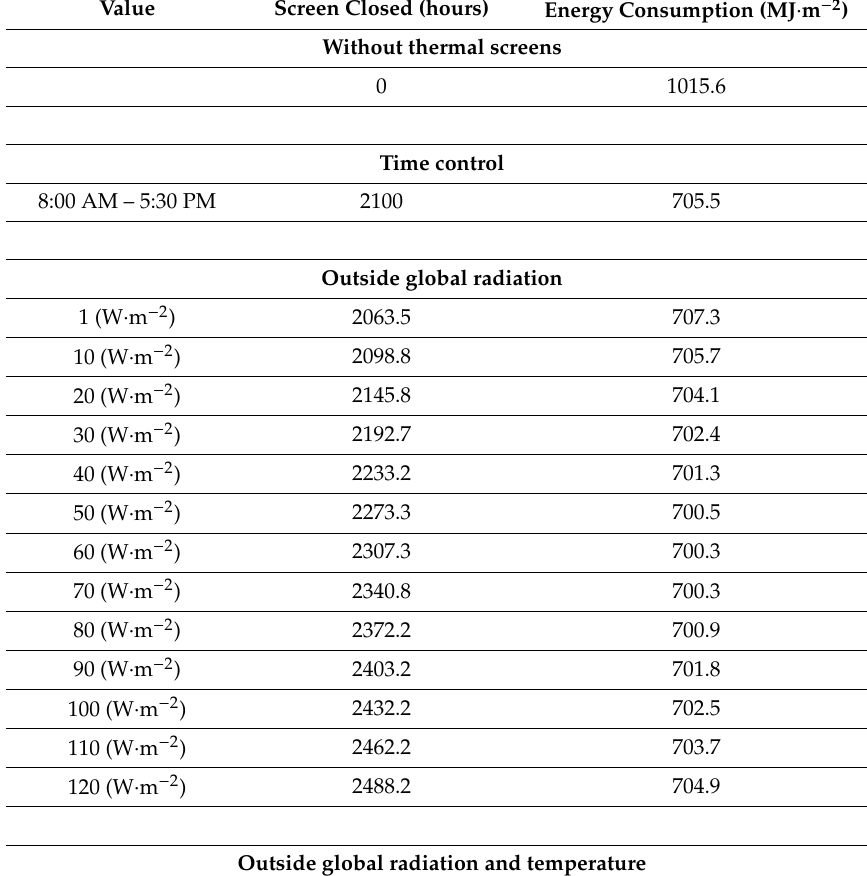
Table 9. Results for di ff erent screen opening strategies.